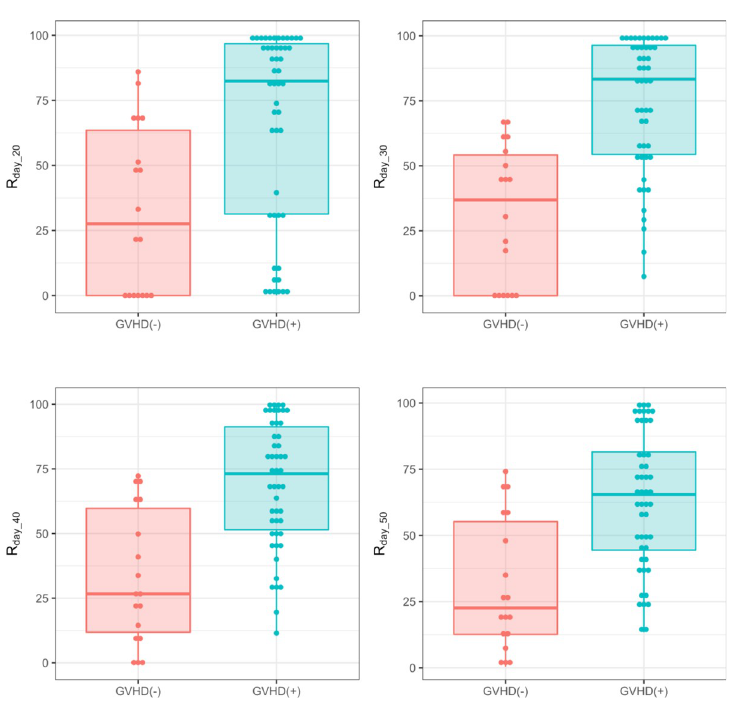
Fig 3. Box plots comparing R day_n values between GVHD (+) and GVHD (–). GVHD (+) and GVHD (-) indicate patients with and without aGVHD. A thick line in each box indicates the median value of R